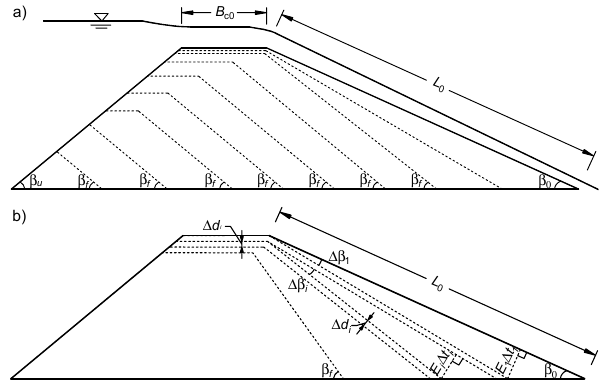
Fig. 2. Longitudinal breach growth. ( a ) longitudinal breach development; ( b ) steepening of the downstream slope.